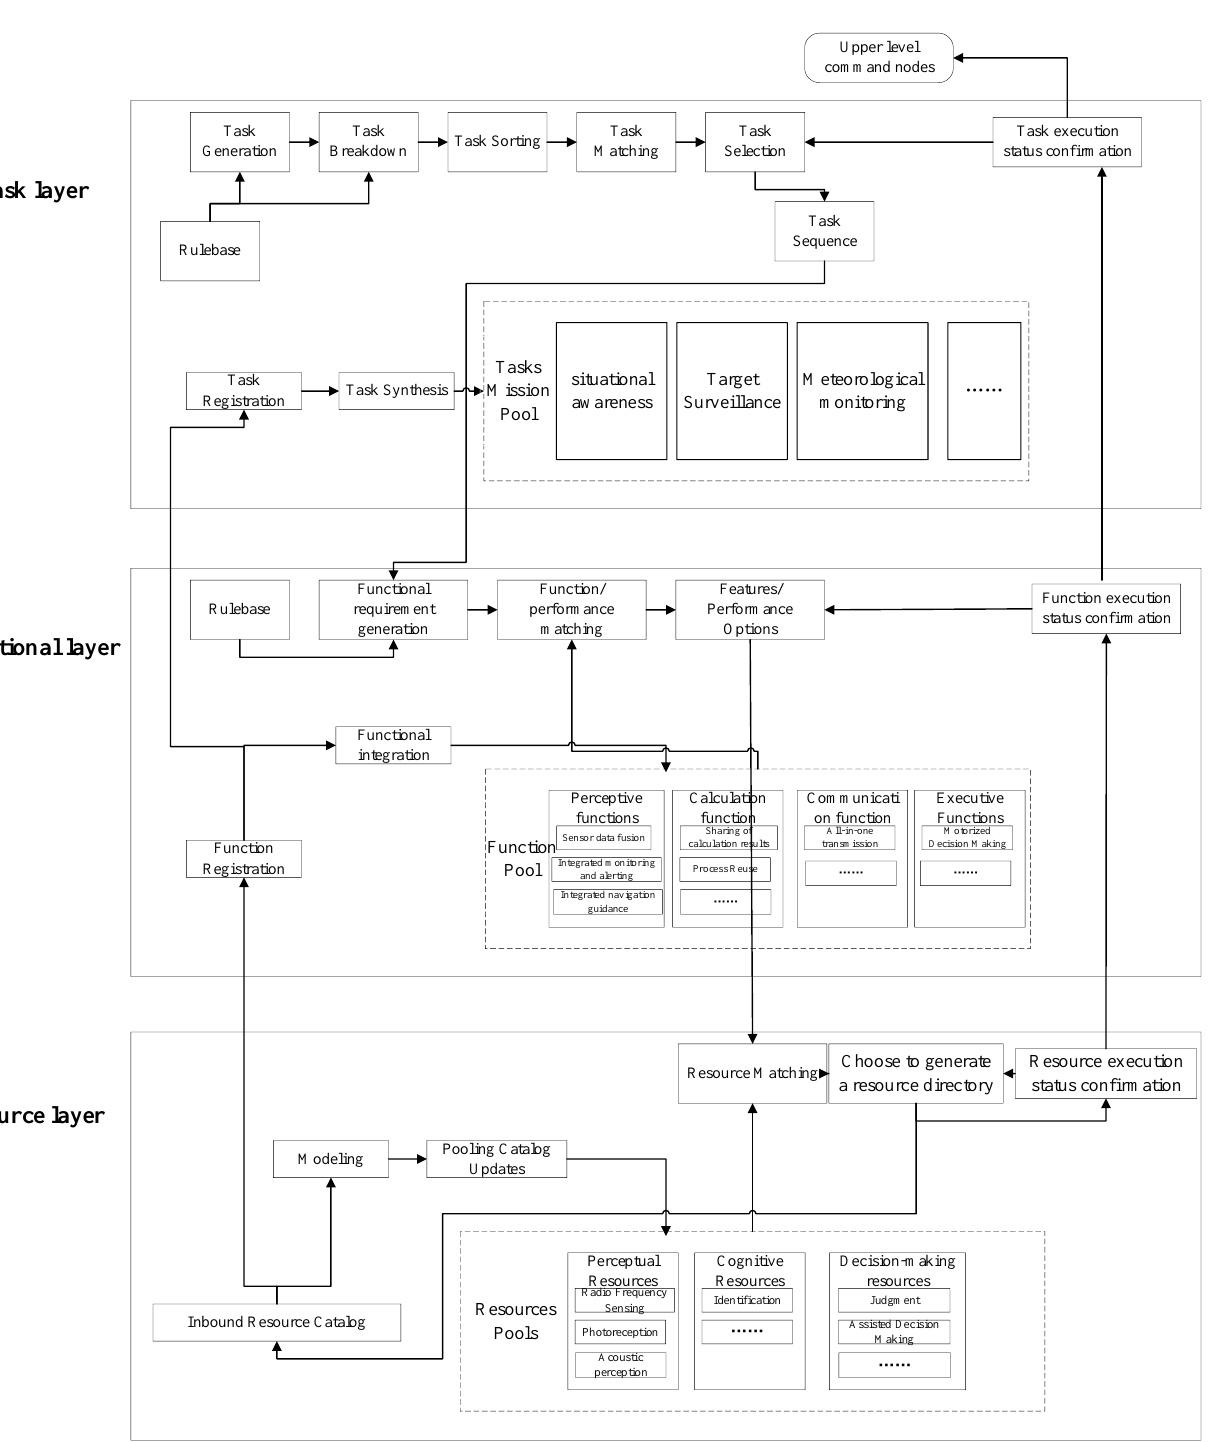
Figure 4. Avionics Cloud hierarchical logic